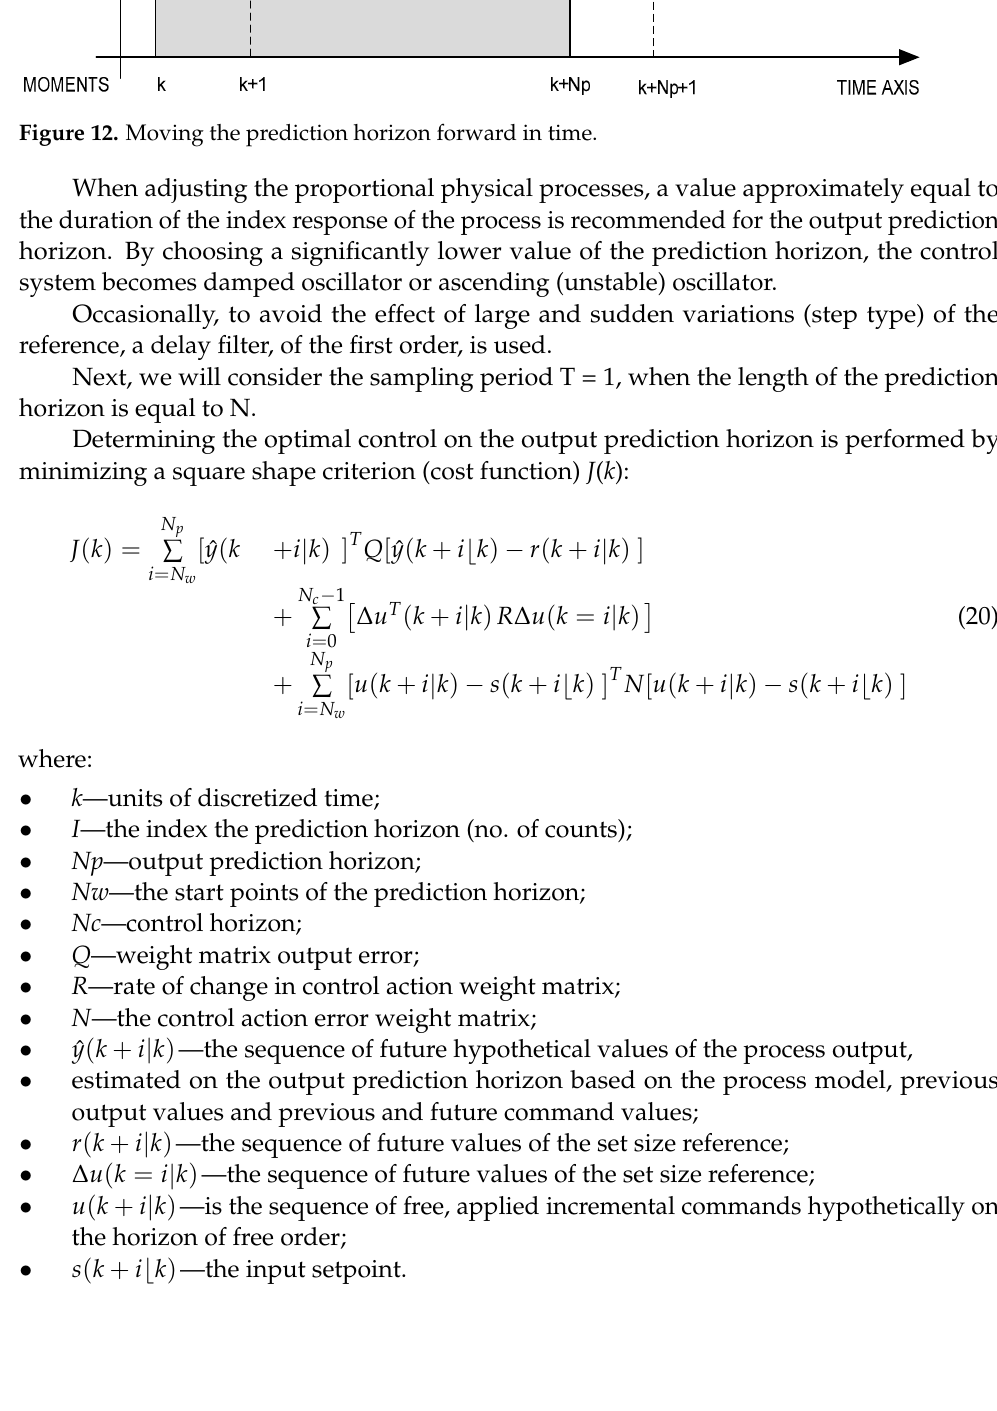
Figure 12. Moving the prediction horizon forward in time.